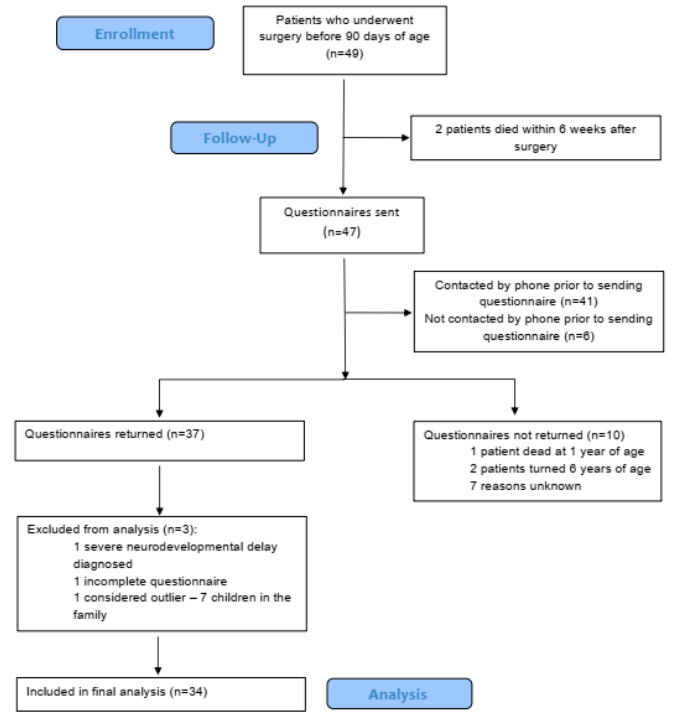
Figure 1. Flowchart of patients included in the psychological assessment.